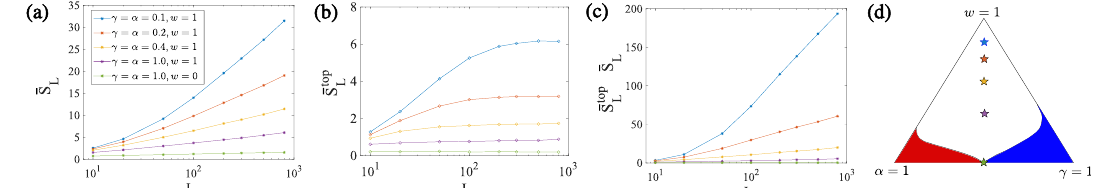
Figure 7: System size scaling of the averaged (a) half-cut entanglement entropy ¯ S (b) Topological entanglement entropy, ¯ S top data points correspond to in the phase space.